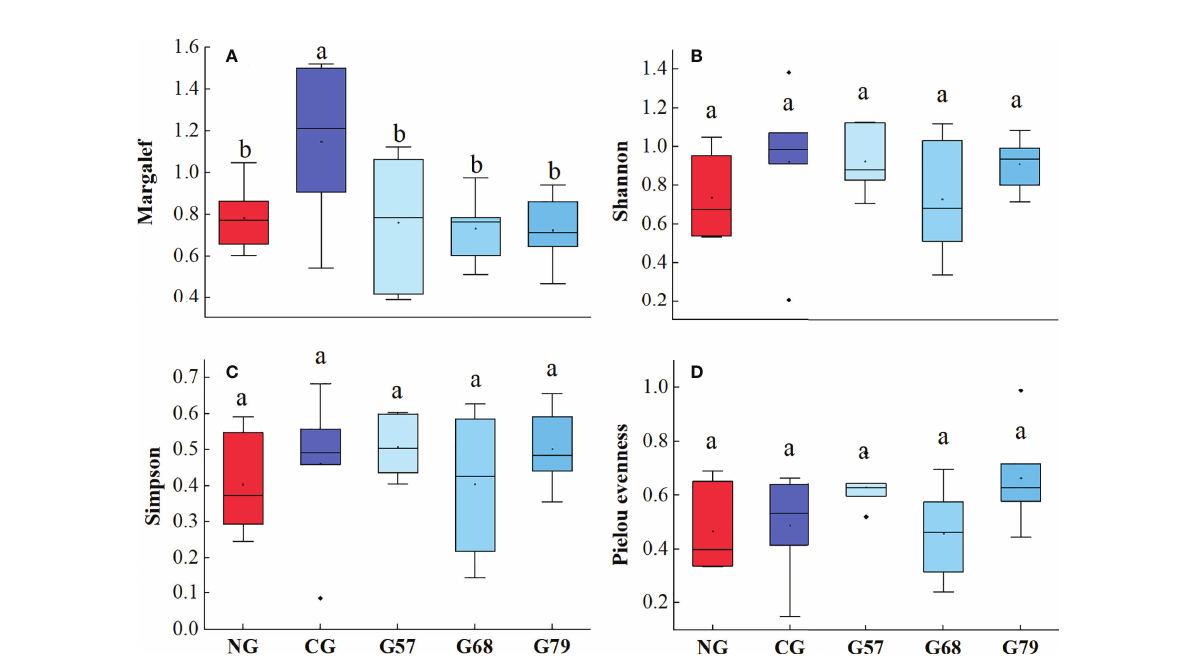
FIGURE 4 Aboveground plant diversity indicators in fi ve grassland management treatments: (A) Margalef; (B) Shannon; (C) Simpson; (D) Pielou evenness. NG: No grazing; CG: Continuous grazing; G57: Grazing in May and July; G68: Grazing in June and August; G79: Grazing in July and September. The error bars in the fi gure represent the standard error, and the lowercase letters represent the signi fi cant differences ( P <0.05).